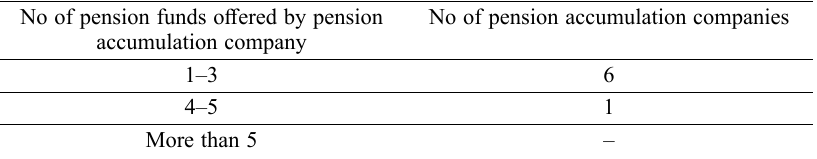
Table 5. Breakdown of supply of second pillar accumulation companies in Latvia No of pension funds offered by pension No of pension accumulation companies accumulation company